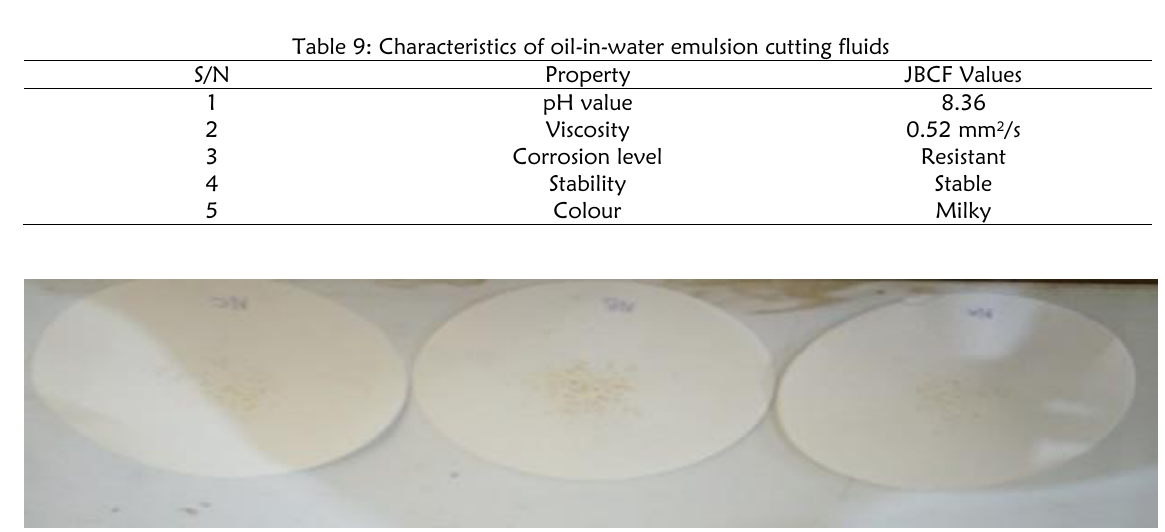
Figure 5: JSO formulated cutting fluids samples corrosion